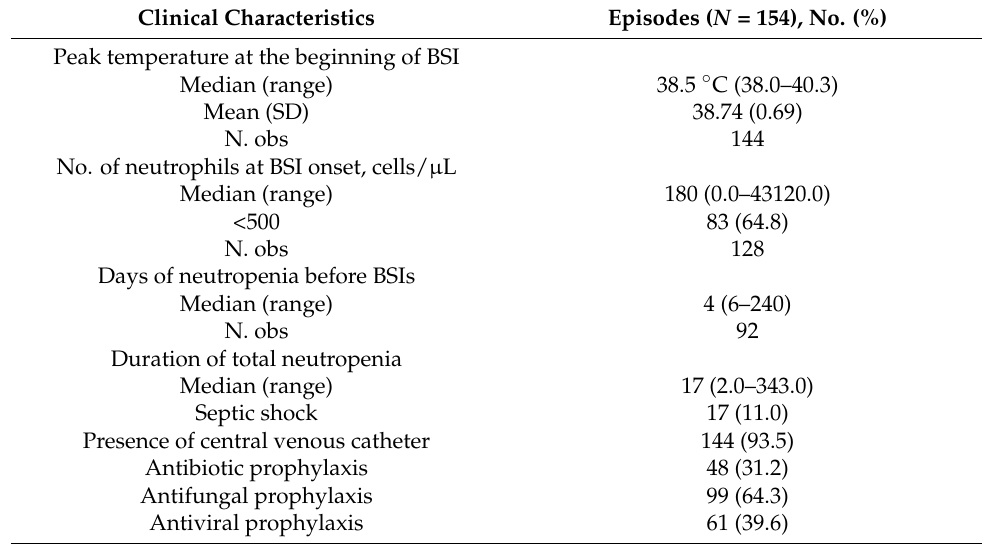
Table 1. Clinical characteristics of 154 episodes of bloodstream infections (BSIs).